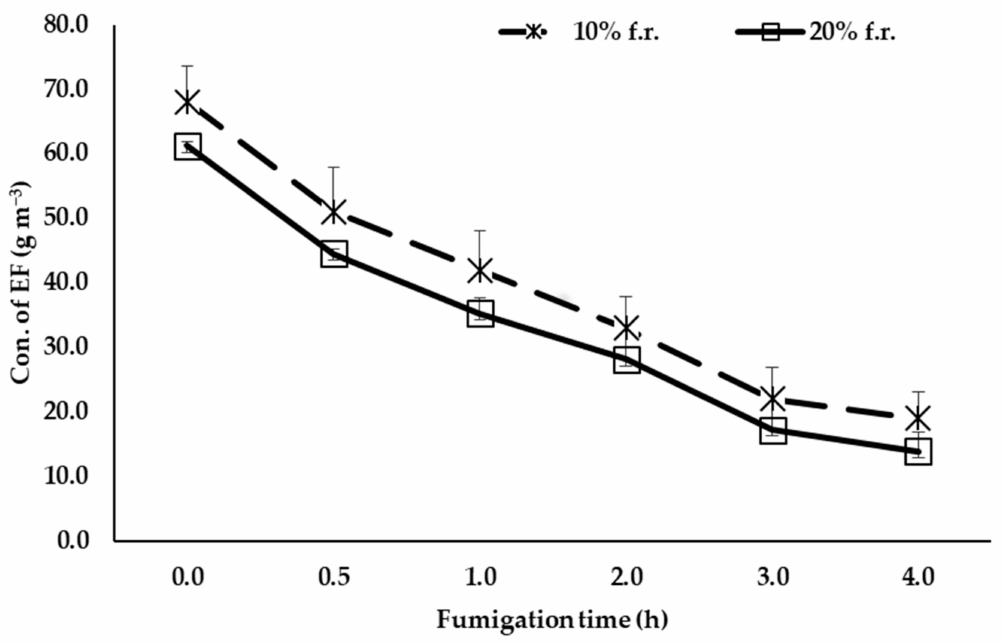
Figure 4. Concentration of EF during large-scale (10 m 3 ) fumigation.